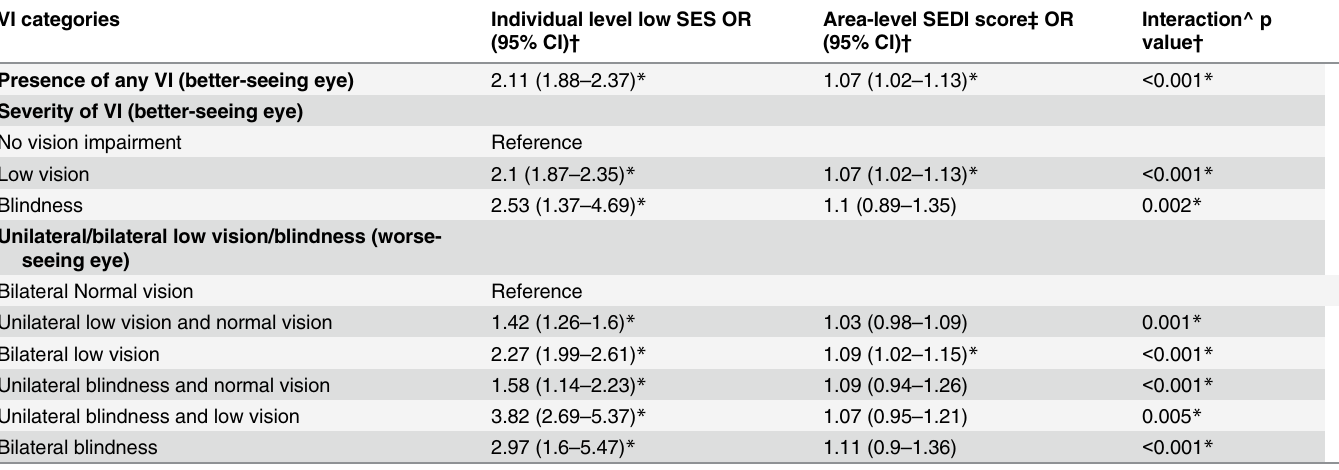
Table 3. Multi-level analysis of individual and area-level SES with the presence and severity of visual